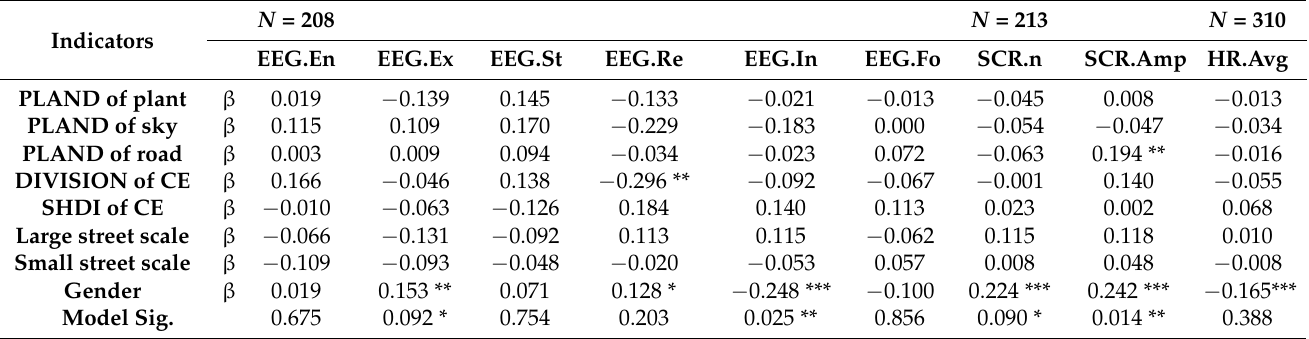
Table 4. Results of the linear regressions of the constituent-element characteristics on the physiological indicators.